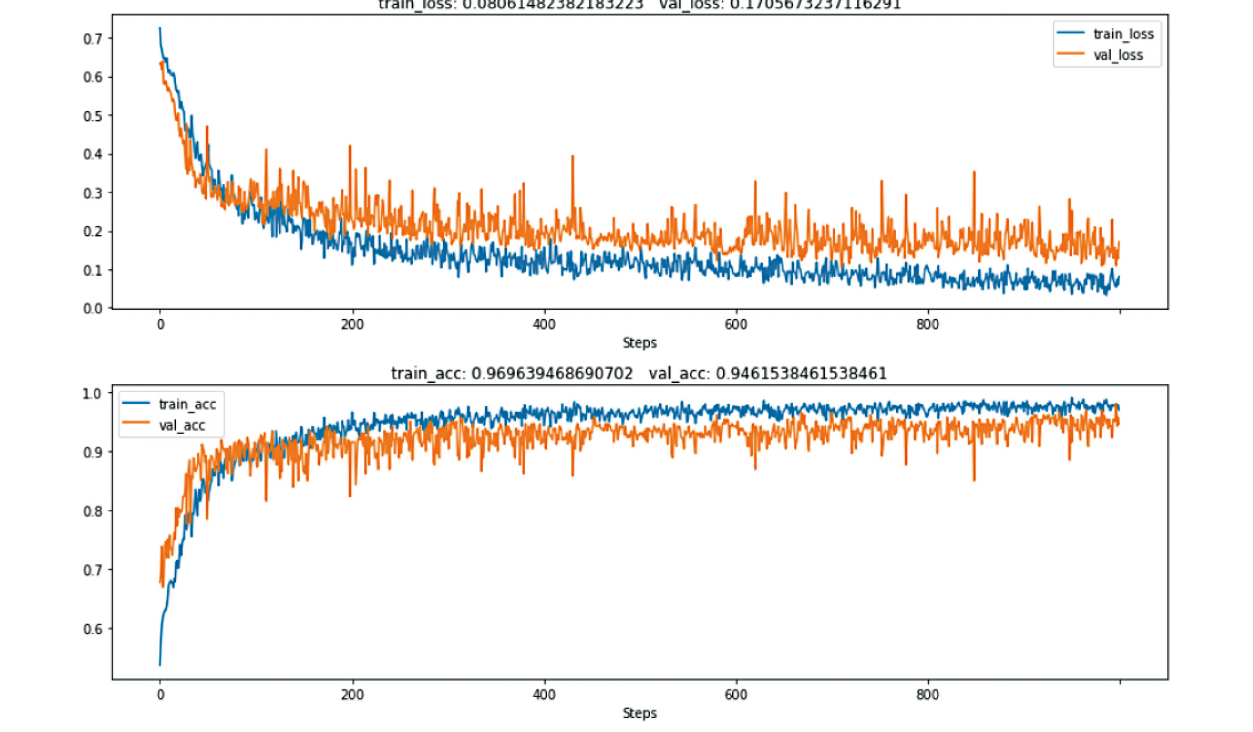
SPSS (version 25) was used for statistical analysis. Categorical variables were summarized as number (percentages) and analyzed by Pearson’s Chi-squared test. Continuous variables were presented as mean ± continuous variables and analyzed by T -tests. The significance of differences was accepted at p <